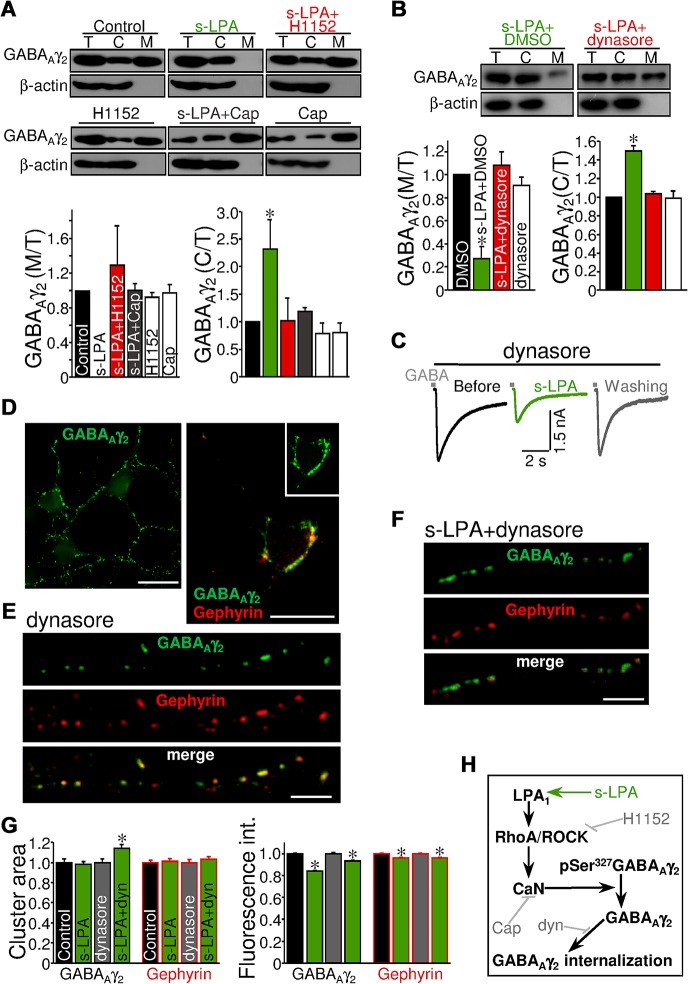
LPA induces dephosphorylation and internalization of the GABAAγ2 subunit in a ROCK/CaN-dependent manner.(A, B) Western blot (top) and averaged ratio (bottom) of total (T), cytosolic (C), and membrane-associated (M) GABAAγ2 in cultured SMNs incubated (10 min) with aCSF alone (control) or supplemented with indicated drugs (A). Dynasore (80 μM) or vehicle (0.2% DMSO) were added to the incubation solution 30 min before subsequent s-LPA coaddition for 10 min (B). β-actin was an internal loading reference for T and C fractions and an indicator for fractionation purity. The average densitometric signals for the GABAAγ2 C and M samples were expressed as a fraction of T GABAAγ2 of the same samples and normalized to the corresponding ratio determined for samples representing control conditions. *p < 0.05, one-way ANOVA on Ranks relative to control or vehicle condition. (C) Same as in Fig 6C under indicated treatments. Treatment with dynasore began at least 30 min before patch performance and was present all along the recording protocol. (D) Left, low-magnification photomicrographs showing a group of SMNs at 6 days in vitro treated for 40 min with aCSF alone and stained for GABAAγ2. Right, detail of a SMN exemplifying close association between GABAAγ2- and gephyrin-ir clusters. (E, F) Examples of GABAAγ2- and gephyrin-ir clusters in the surface of neurites obtained from SMNs treated for 40 min with dynasore (E) or 30 min with dynasore plus 10 min with s-LPA+dynasore (F). Scale bars: D, 50 μm; E, F, 5 μm. (G) Normalized mean cluster area (left) and fluorescence intensity (right) of GABAAγ2- and gephyrin-ir clusters analyzed under the indicated treatments (n > 1,200 clusters per condition). *p < 0.005, Student’s t test relative to control or dynasore condition. (H) Diagram of the proposed pathway mediating LPA-induced STD on GABAAR-mediated neurotransmission. Drug targets are also indicated. Plots data can be found in S1 Data.